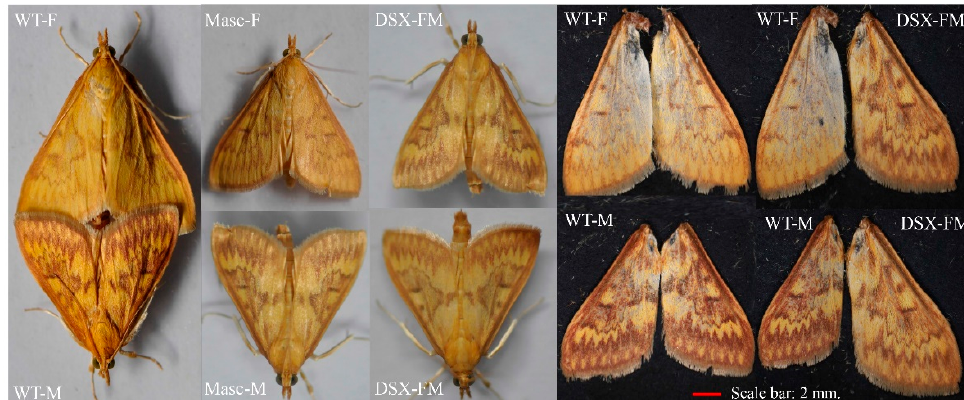
Figure 4. The pigmentation of the wild-type individuals compared with the OfMasc and Ofdsx mu- tants. In the wild type, the wing color of males is deeper than that of females. In the OfMasc mutant males, the wing color was weaker than in wild-type males. In the Ofdsx mutants, the wing color had a level of pigmentation between that of the wild-type males and females. Scale bar: 2